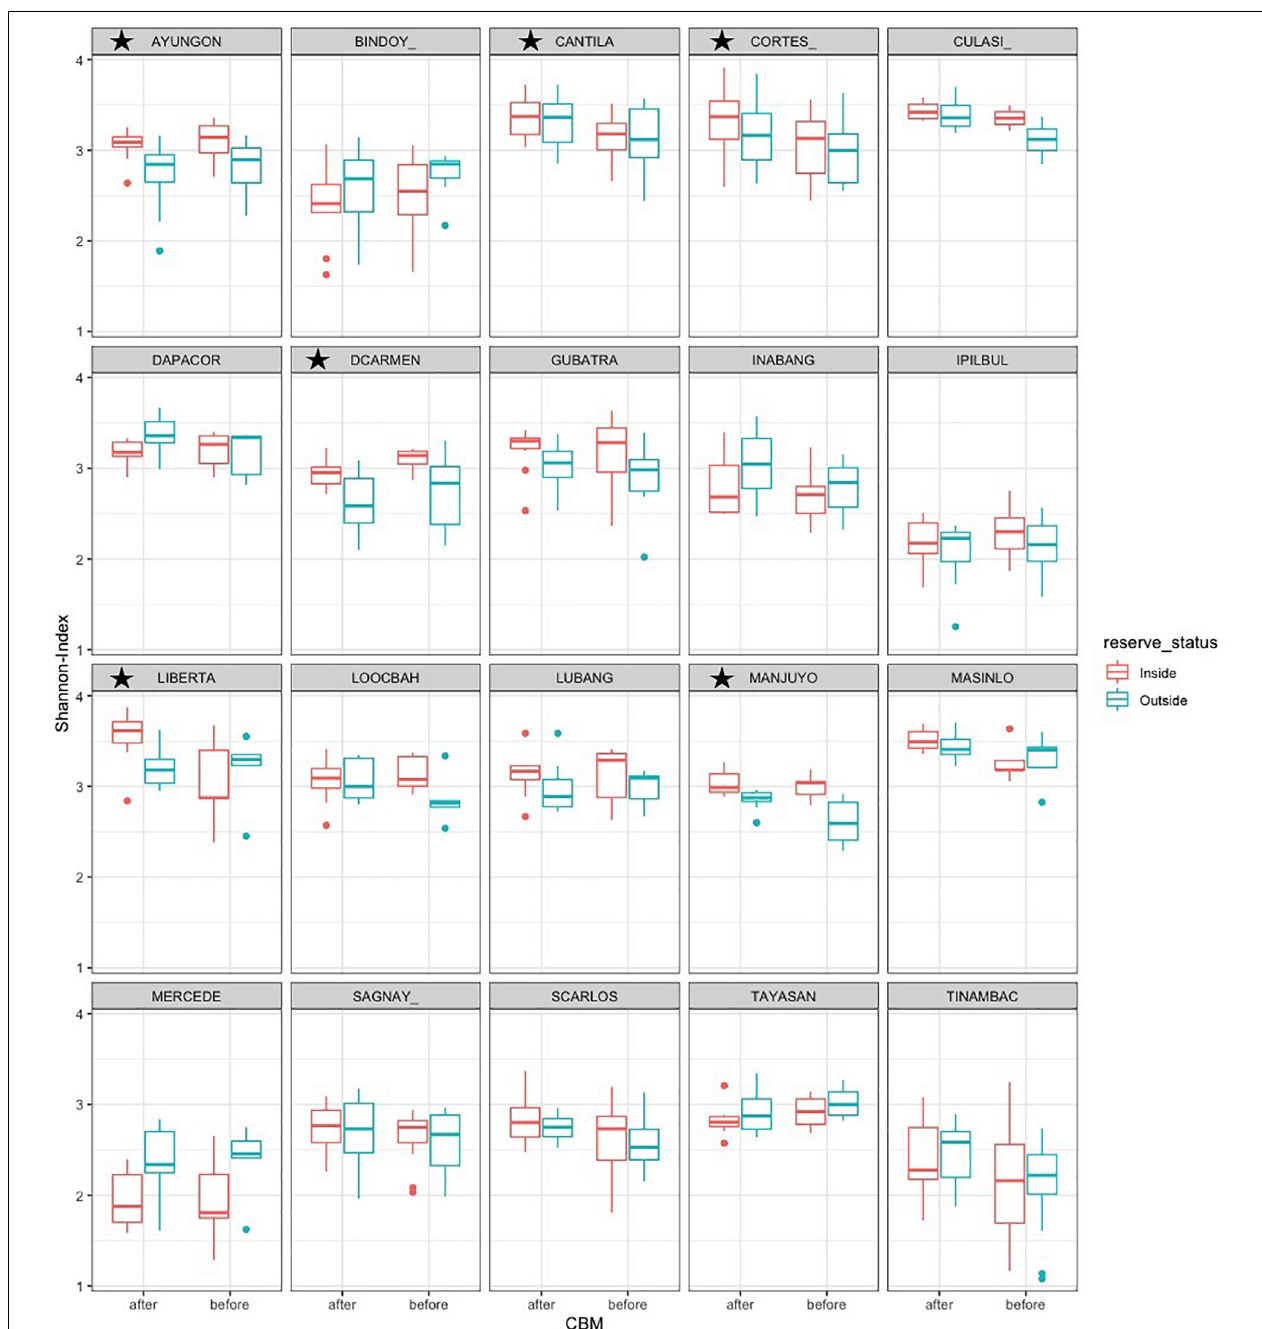
FIGURE 9 | Biodiversity index inside and outside marine reserves before and after CBM. * Indicates the interaction between CBM and reserve status at each site is P <